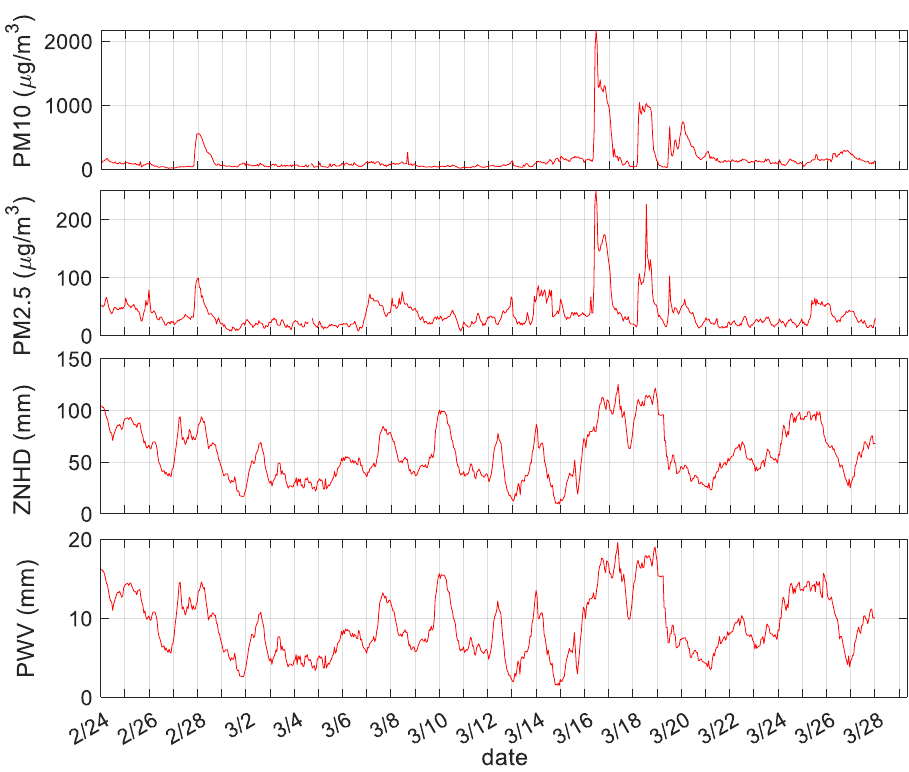
Figure 5. Changes in PM10, PM2.5, ZNHD and PWV at NXZW station. As can be seen from Figure 5, from the 27th of February to the 28th of February, a small-scale dust storm occurred in Zhongwei City, and both PM10/PM2.5 and ZNHD/PWV increased significantly. The concentrations of PM10 were greater than 7000 μg/m 3 , about 32 times higher than usual on the 15th of March 2021. The concentrations of PM2.5 were greater than 1000 μg/m 3 , about 7.5 times higher than usual on the 15th of March 2021. It can be seen that Zhongwei City in the Ningxia Hui Autonomous Region, was greatly affected by the sandstorm on the 15th of March 2021. On the 15th of March 2021, the change trend of ZNHD/PWV was very consistent with the change trend of PM10/PM2.5. The ZNHD and PWV exceed 100 mm and 15 mm respectively, reaching 2 – 3 times the usual. From the 25th of March to the 27th of March, ZNHD/PWV increased significantly. According to the website of the China Meteorological Administration, there was obvious rainfall and light haze in Zhongwei City during this period.